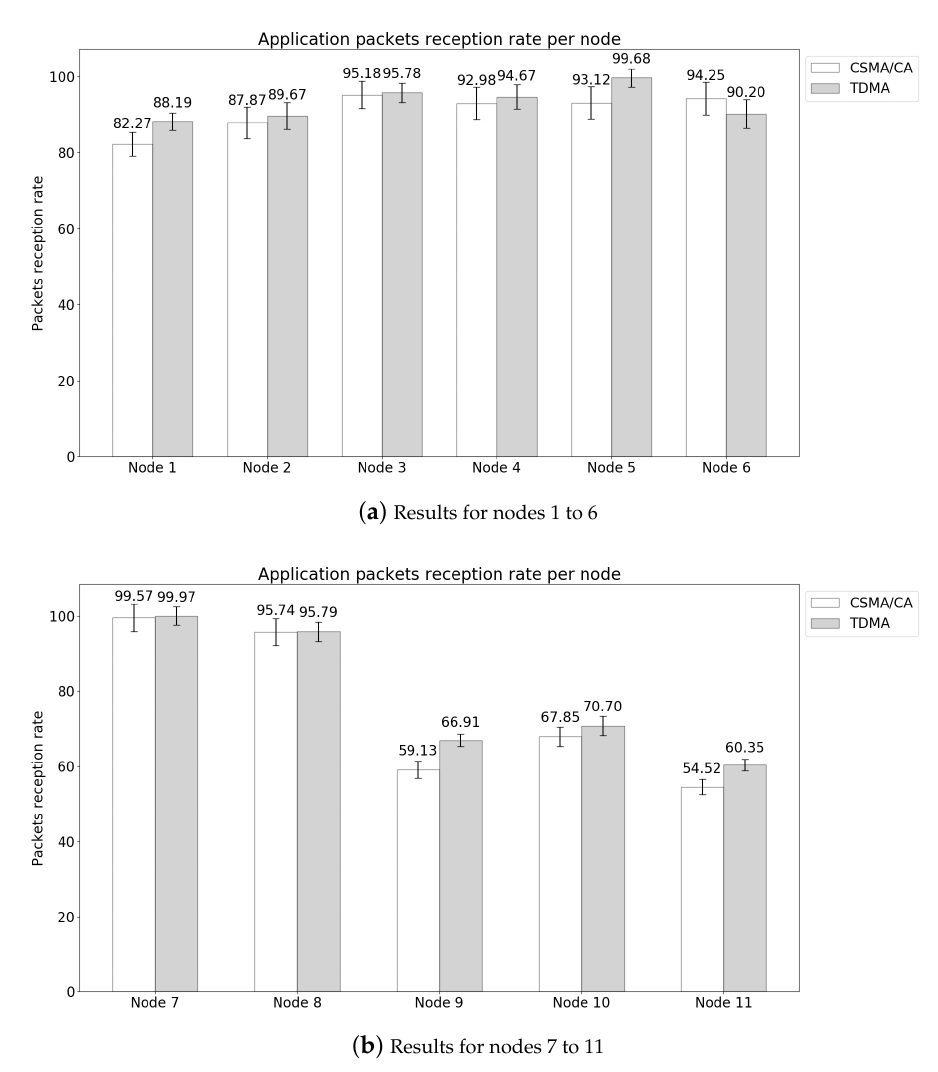
Figure 13. Application PDR for the 12 nodes